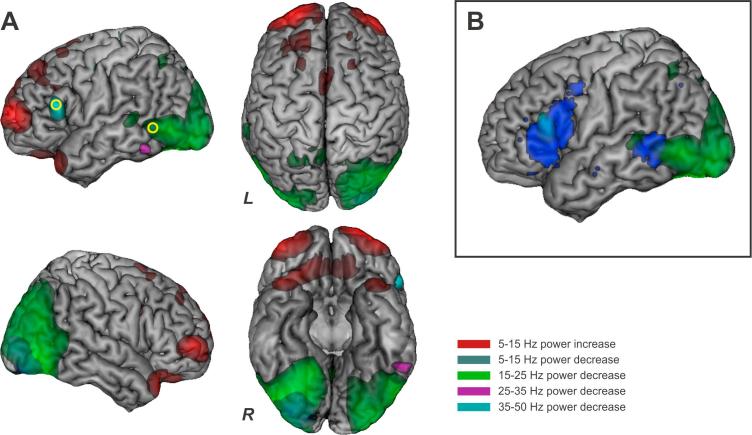
(A) Three-dimensional rendered images of the neuronal responses at 200–400 ms during the task performance compared to pre-trial baseline (p = .01 corrected); different colours refer to different frequency bands and power changes: power increases at 5–15 Hz are represented in red. The remaining colours indicate power decreases at 5–15 Hz in blue (overlaid in the picture with green), at 35–50 Hz in cyan, at 25–35 Hz in purple and at 15–25 Hz in green. POIs are shown as yellow circles. (B) The POIs selected for the time-frequency analysis fall within regions implicated in both semantic control and verb processing identified by fMRI meta-analyses. The blue map represents the brain regions in common between the semantic retrieval network and the verb/action knowledge map presented in . The clusters in LIFG and LPMTG reported in the blue map overlap with the neural responses observed in whole brain beamforming analysis at 35–50 Hz and 15–25 Hz. (For interpretation of the references to colour in this figure legend, the reader is referred to the web version of this article.)